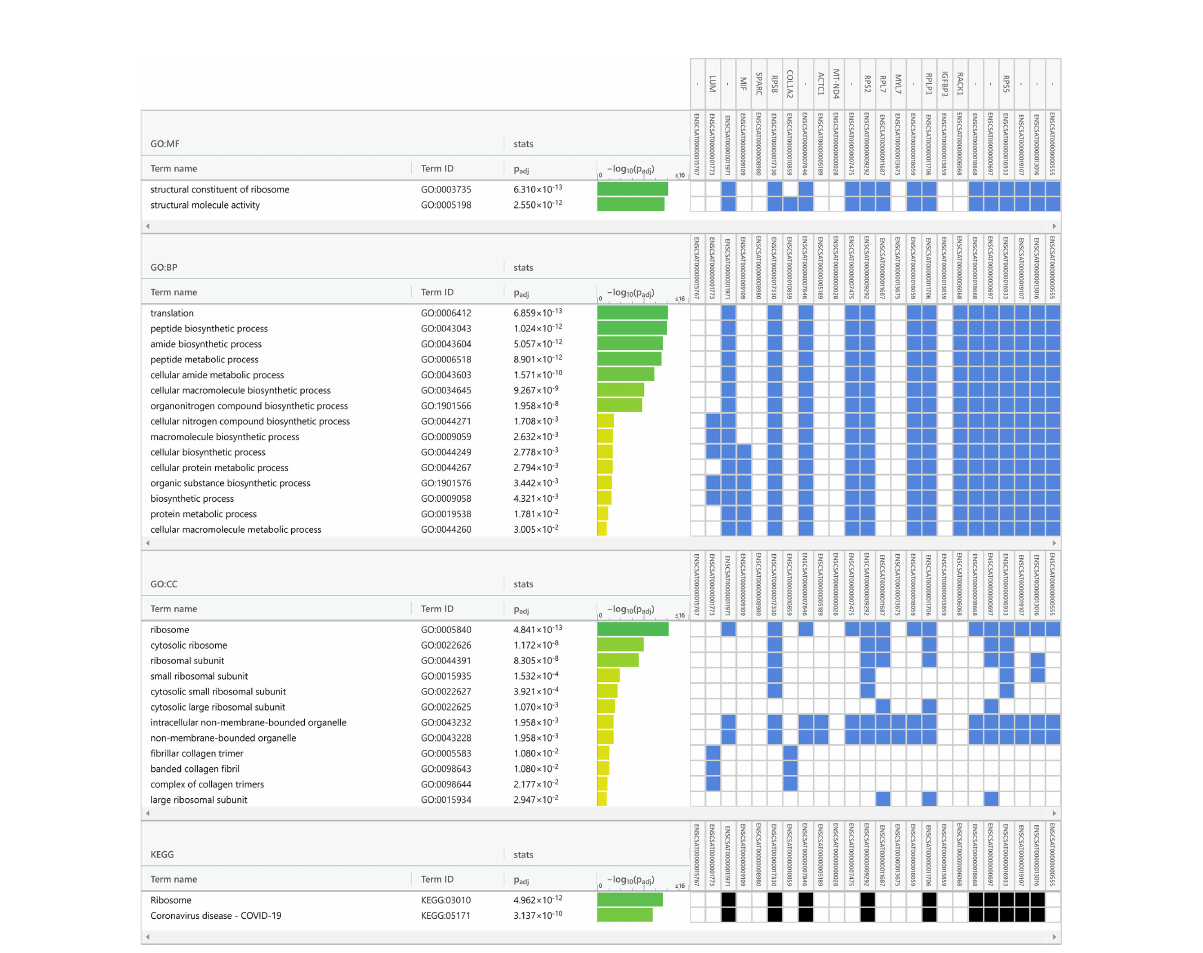
FIGURE 5 Functional enrichment analysis of the infected Vero cell m6A epitranscriptome (dataset from Campos et al., 2021). A total of 24 transcripts common to infected cells was used in enrichment analysis (Table 1), with Gene Ontology and KEGG biological pathways as data sources for overrepresentation. The analysis was performed with default gPro fi ler web server options, with g:SCS algorithm for computing multiple testing correction for p -values. Terms are grouped by data sources (Gene Ontology classi fi cations or KEGG biological pathways). The GO categories are in the left columns, green bars indicate the -log 10 of the p -value, blue and black squares indicate signi fi cant positive hits of the transcript IDs (vertical top columns) with GO categories. GO : MF, Molecular Function; GO : BP, Biological Process; GO : CC, Cellular Component and KEGG, Kyoto Encyclopedia of Genes and